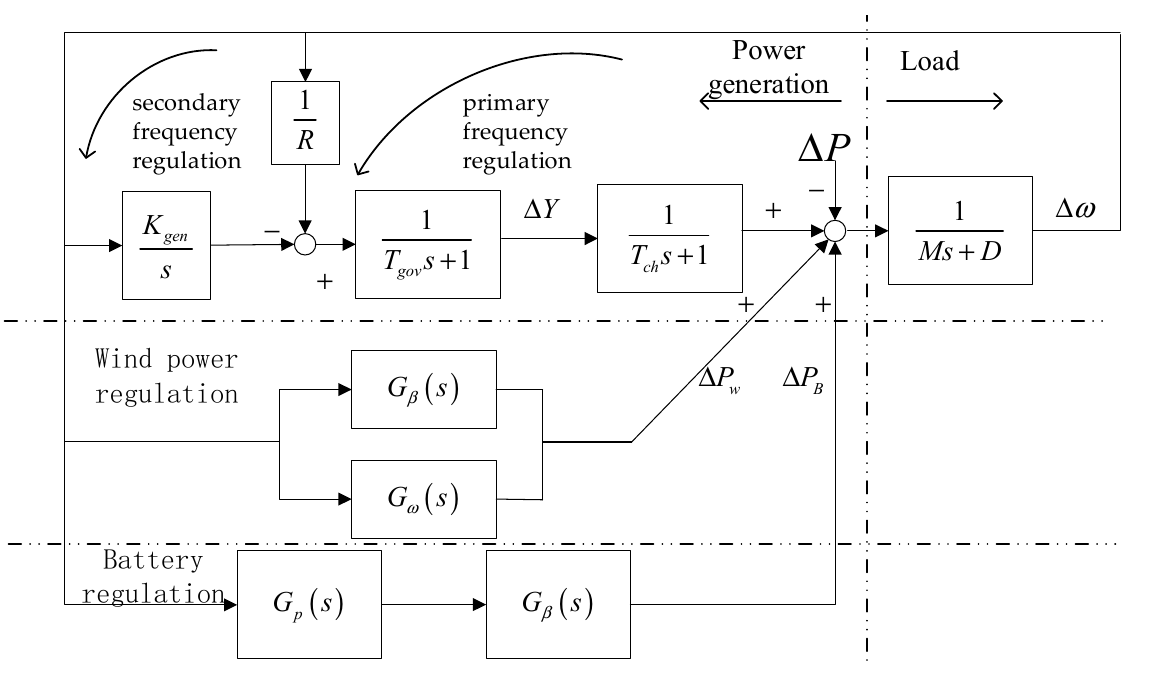
Figure 7. Power system with wind power and energy storage.